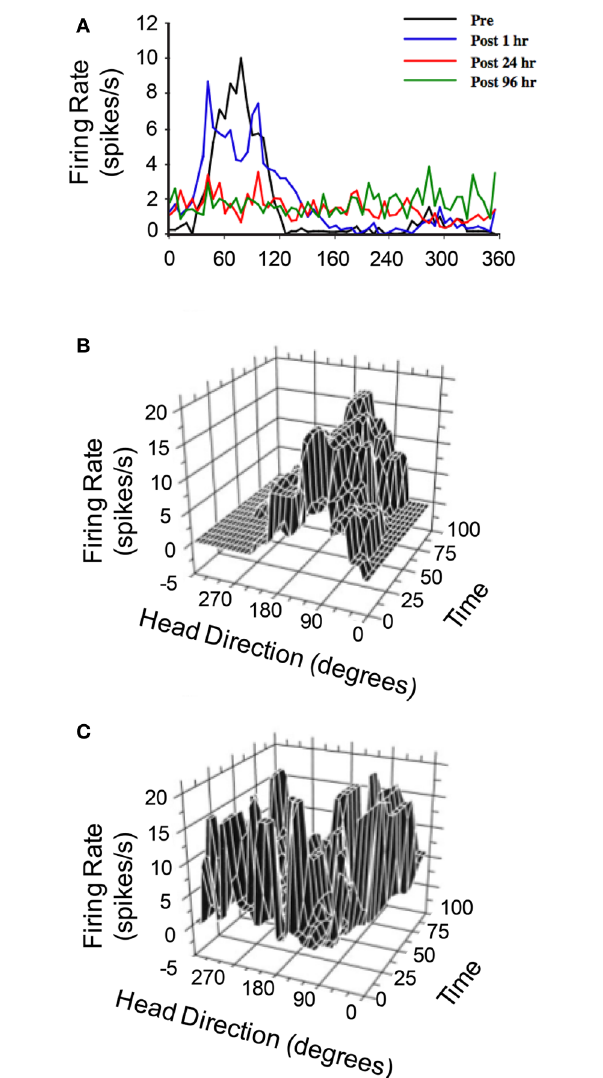
FIGURE 4 | (A) Responses of anterodorsal thalamic HD cells to sodium arsanilate lesions of the vestibular labyrinth (from Stackman and Taube, 1997). In general, disruption of the vestibular labyrinth abolished HD tuning shortly after the lesion and persisted up to 96h after the lesion during which the cell was monitored. (B,C) 3D plot of firing rate and HD as a function of time in epochs of 5s duration of a distinct anterodorsal thalamic HD cell recorded before vestibular lesion (B) and a non-directional anterodorsal thalamic burst cell recorded after vestibular lesion (C) . For both plots, unit activity was recorded over 8min sessions, during which the rat foraged in a cylindrical apparatus. The post-lesion bursty cell depicted in (C) exhibited a characteristic pattern of intermittent high firing rate events that were neither related to the rat’s HD nor temporally organized. Plots in (A–C) are modified from Stackman and Taube